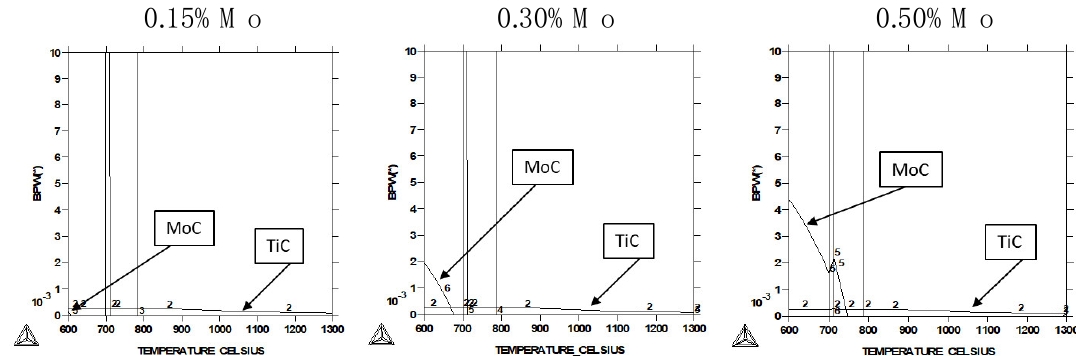
Figure 7. Thermocalc calculations (database SSOL4) of stable carbide phases of molybdenum and titanium in the present steels.